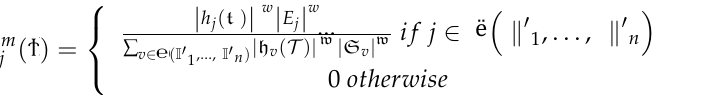
Figure 3. 4-BSMAB best activation visualizations of an image at various convolutional layers: ( a ) original image; ( b ) C1_1; ( c ) C2_1; ( d ) C2_2; ( e ) C3_1; ( f ) C3_2; ( g ) C4_2; ( h ) C7_1.